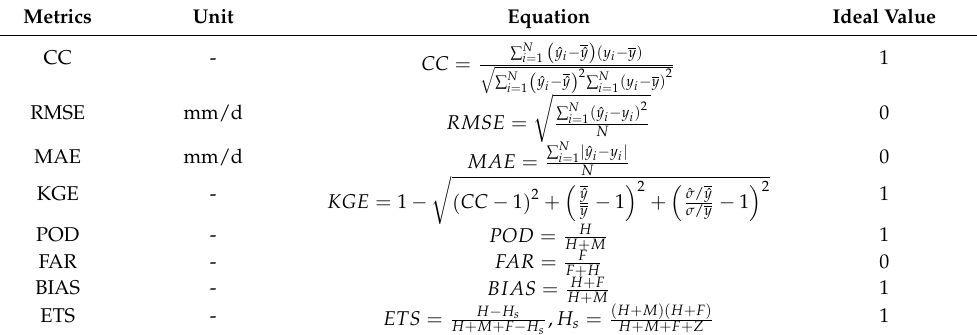
Table 2. The evaluation metrics for precipitation product